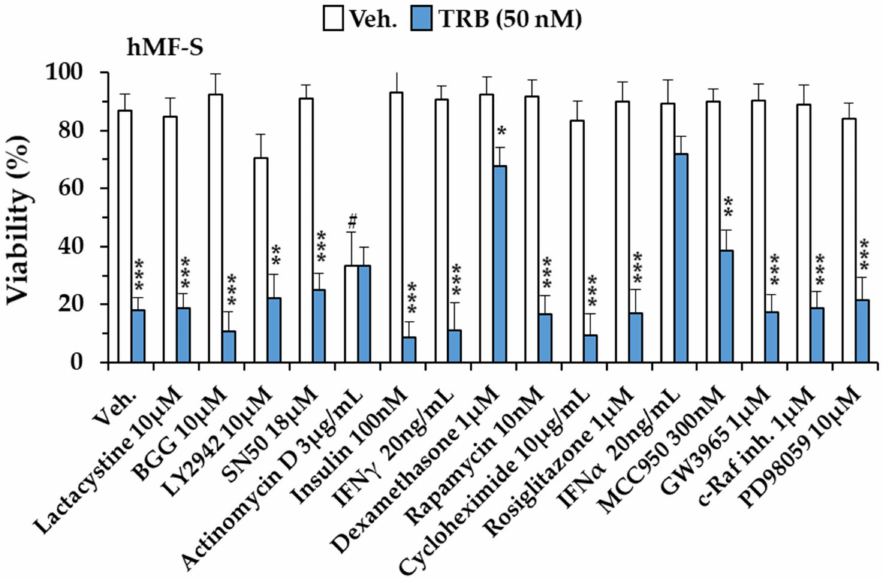
Figure 5. Immuno-metabolic effects of TRB and LUR on hMF inhibition of glycolysis, fatty acid biosynthesis, and glutamine metabolism. ( a ) hMFs were treated with the indicated inhibitors, and viability and ROS productionweremeasuredat24h;10 µ M3PO(3-pyridin-3-il-1-piridin-4-ilprop-2-en-1-one;aPFKFB-3inhibitor); 1 µ g / mL TOFA (5-tetradeciloxi-2-furoicacid; an ACC inhibitor); 40 µ M C968 (968 compound; a mitochondrial glutaminase inhibitor); ( b ) immuno-metabolic modulation assay with lactate (20 µ M), succinate (100 µ M), and dimethyl-fumarate (100 µ M). hMF viability and ROS production were measured at 24 h. Results show the means + S.E.M. from 5 different donors, * p < 0.05 vs. the control immune-metabolic untreated condition. a.u., arbitrary